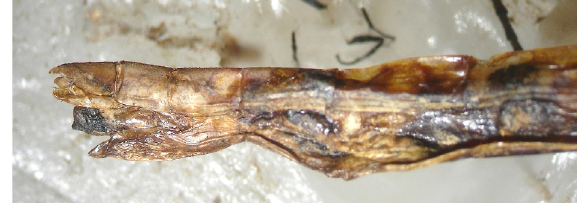
Image 3. End of abdomen showing anal segment and operculum.